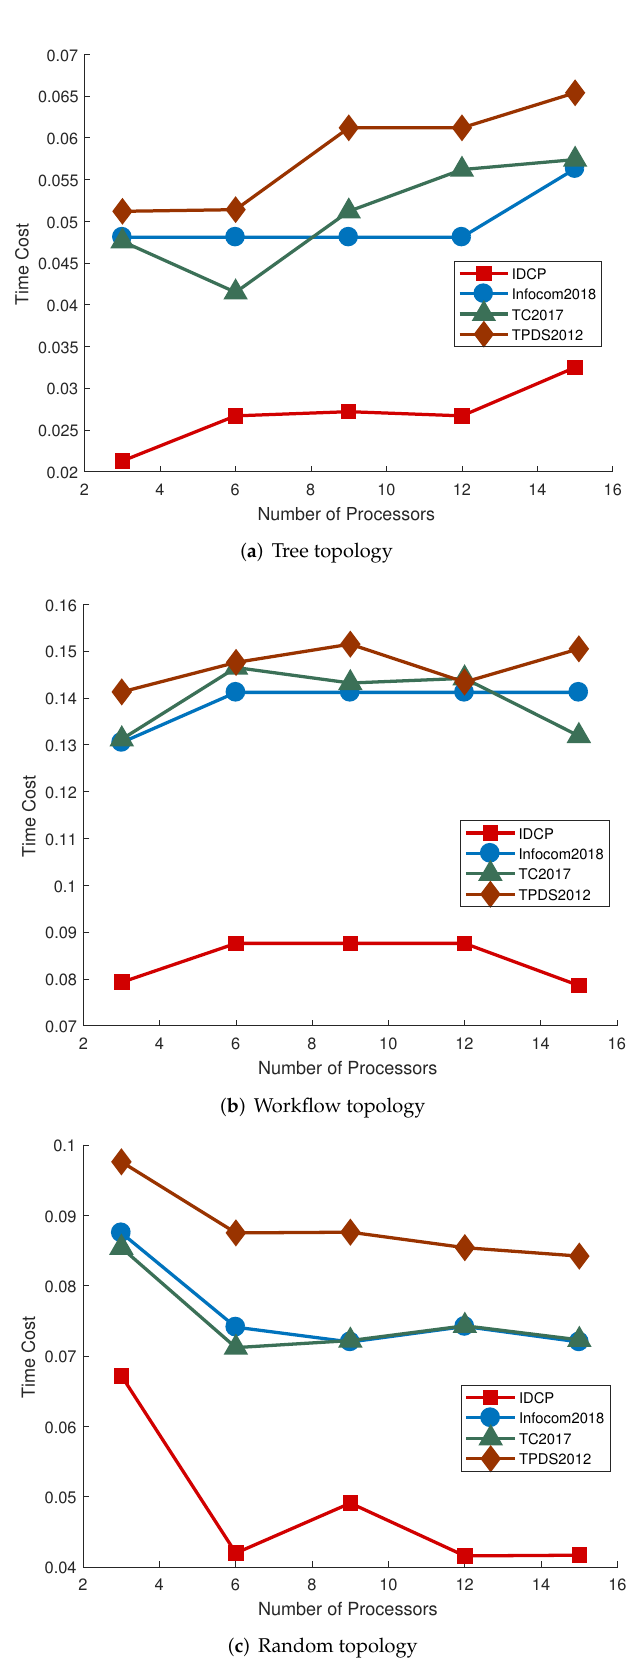
Figure 6. Time cost of different topologies under the number of